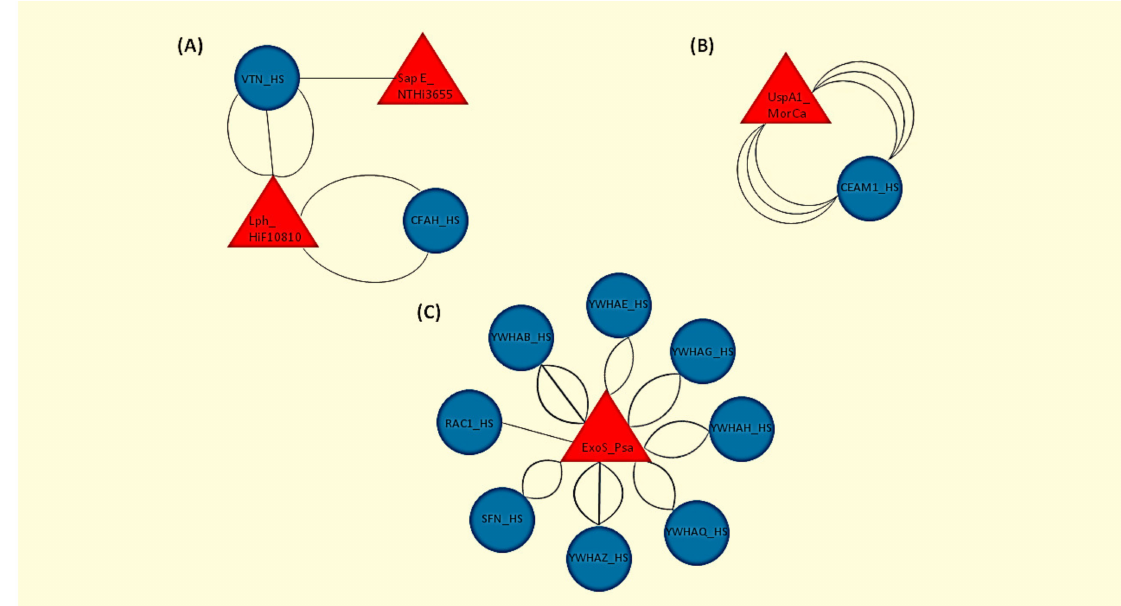
Figure 1. Graphical representation of the human-bacterial protein interactions as retrieved by the Host Pathogen Inter- action Database version 3.0 (HPIDB 3.0). Human (Homo Sapiens, HS) proteins are shown in blue circles and bacterial strains are shown in red triangles. Each line represents a different experimental assay used to detect each interaction. ( A ) Hif strain 10810 interaction with CFAH; Hif strain 10810 and NTHi strain 3655 interaction with VTN. ( B ) MorCa interaction with CEAM1. ( C ) Psa interaction with YWHAB (tyrosine 3-monooxygenase/tryptophan 5-monooxygenase activation protein beta), YWHAE (tyrosine 3-monooxygenase/tryptophan 5-monooxygenase activation protein epsilon), YWHAG (tyrosine 3-monooxygenase/tryptophan 5-monooxygenase activation protein gamma), YWHAH (tyrosine 3- monooxygenase/tryptophan 5-monooxygenase activation protein eta), YWHAQ (tyrosine 3-monooxygenase/tryptophan 5-monooxygenase activation protein theta), YWHAZ (tyrosine 3-monooxygenase/tryptophan 5-monooxygenase activation protein zeta) and SFN (stratifin) (the last seven genes are all members of the 14-3-3 family of protein kinase C inhibitors), and RAC1 (ras-related C3 botulinum toxin substrate